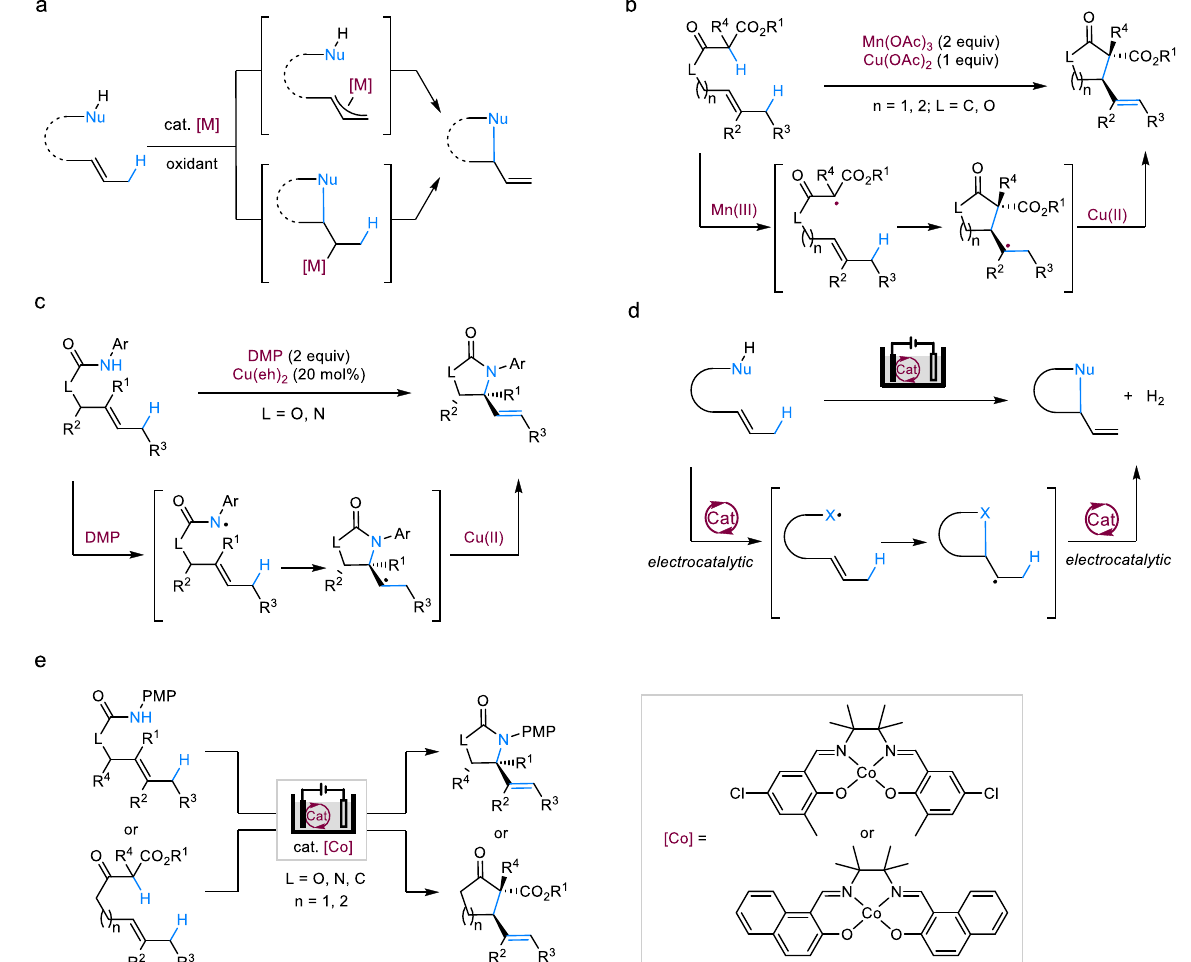
Fig. 1 Intramolecular oxidative allylic C – H functionalization. a Transition-metal catalyzed allylic C – H functionalization usually proceeds through C – H activation to form allyl-metal species or nucleometallation/ β -hydride elimination. b Mn(III)/Cu(II)-mediated intramolecular allylic C – H alkylation of 1,3- dicarbonyl compounds. c DMP-promoted, Cu(II)-catalyzed intramolecular allylic C – H amination. d Proposed electrocatalytic approach to achieve intramolecular allylic C – H functionalization. The electrocatalyst facilitates both the initial substrate oxidation and the conversion of the cyclized alkyl radical to an alkene. e Electrocatalytic intramolecular allylic C – H amination and alkylation enabled by tailored cobalt-salen complexes. DMP Dess – Martin periodinane, Cu(eh) 2 copper(II)